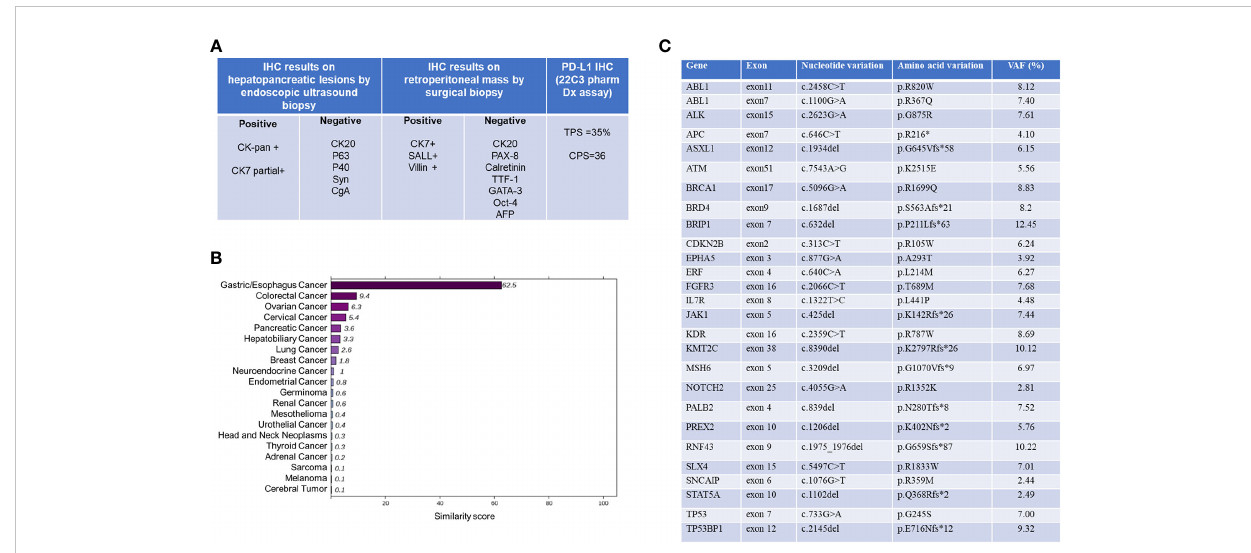
FIGURE 2 Summary of histopathological and molecular pathological information. (A) Pathological and immunohistochemical (IHC) results. (B) 90-gene tumor tissue traceability expression assay results. The maximum similarity score for tumor tissue traceability was 100. (C) Gene expression pro fi le of tissue specimens analyzed by NGS. VAF, variant alle frequency. NGS, Next Generation Sequencing.